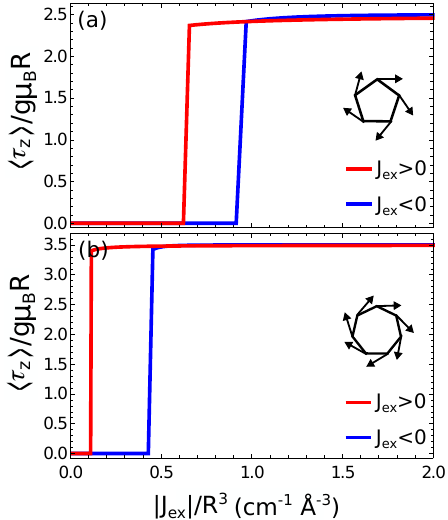
Figure 6. Ground state expectation value of the toroidal moment operator in a five-membered ( a ) and a seven-membered ( b ) Heisenberg ring inclusive of intramolecular magnetic dipole–dipole interactions and ferromagnetic (red) or antiferromagnetic (blue) isotropic exchange coupling J ex . Insets depict the expectation values of the on-site spin for one of the ring ground states below the critical circumscribed radius R ∗ , where a non-zero value of the toroidal moment is